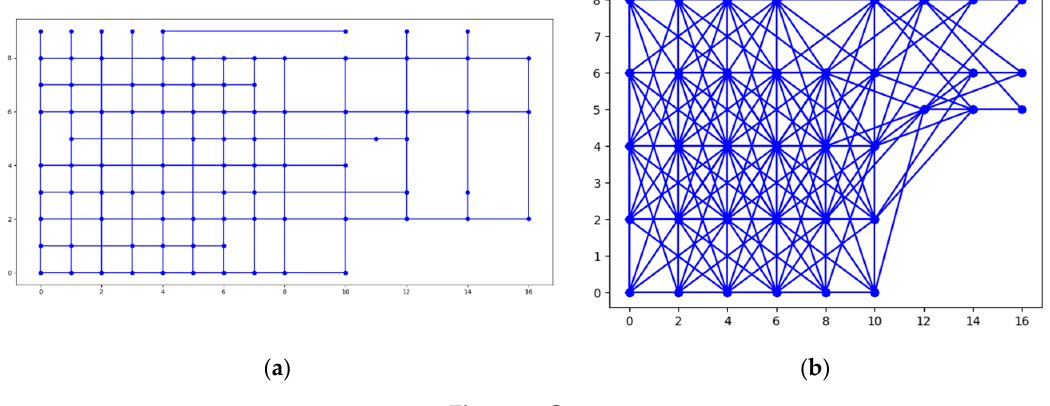
Figure 5. Cont. Figure 6. Cont